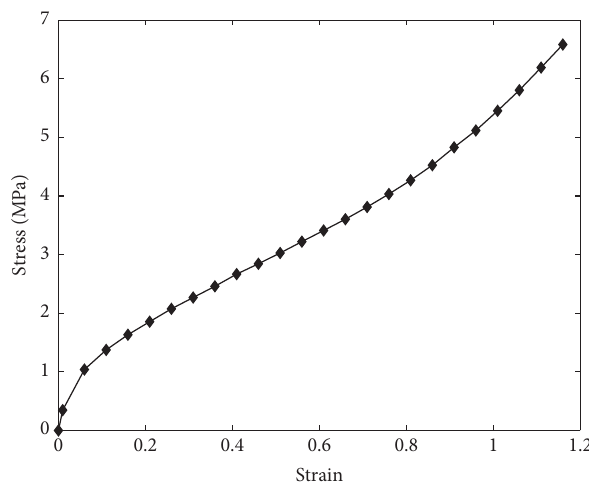
Figure 3: Uniaxial tensile stress-strain of polyurethane rubber